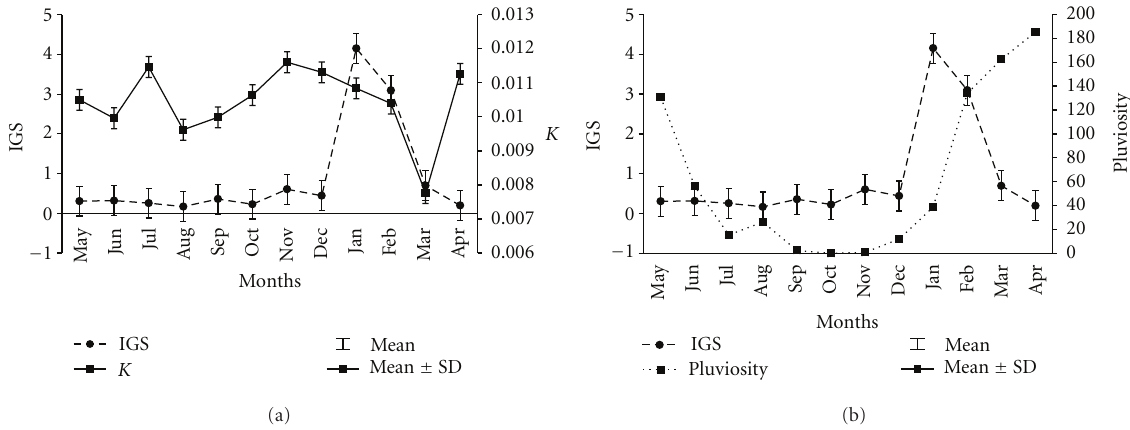
Figure 6: Monthly gonadosomatic index and condition factor of P. brevis (a) and gonadosomatic index of P. brevis and rainfall (b).